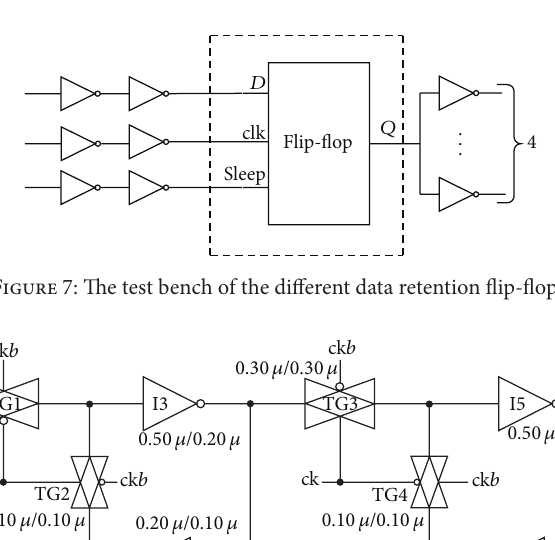
Figure 6: The proposed ADR-FF circuits and its operation timing.